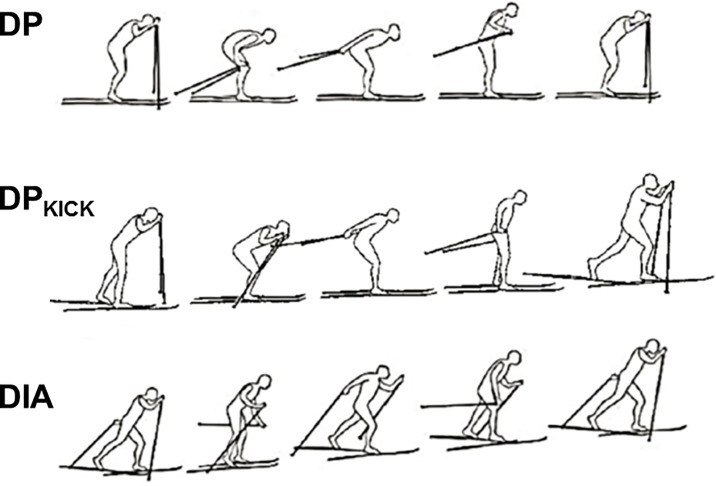
Overview of the techniques (gears) employed in classical cross-country skiing: DP (double poling), a symmetrical technique utilized on flat terrain, involves a pole push phase, which begins just before the skier plants his poles in the snow, and ends when the poles are lifted off the snow behind him.DPKICK (double poling with a kick), employed on flat and slightly uphill terrain, involves a symmetrical poling action followed by a single step or kick with the left or right leg for propulsion. DIA (diagonal skiing), employed uphill, involves a kicking action followed by a weight shift to the gliding ski, after which the skier quickly performs a poling action with the arm opposite the kicking leg.